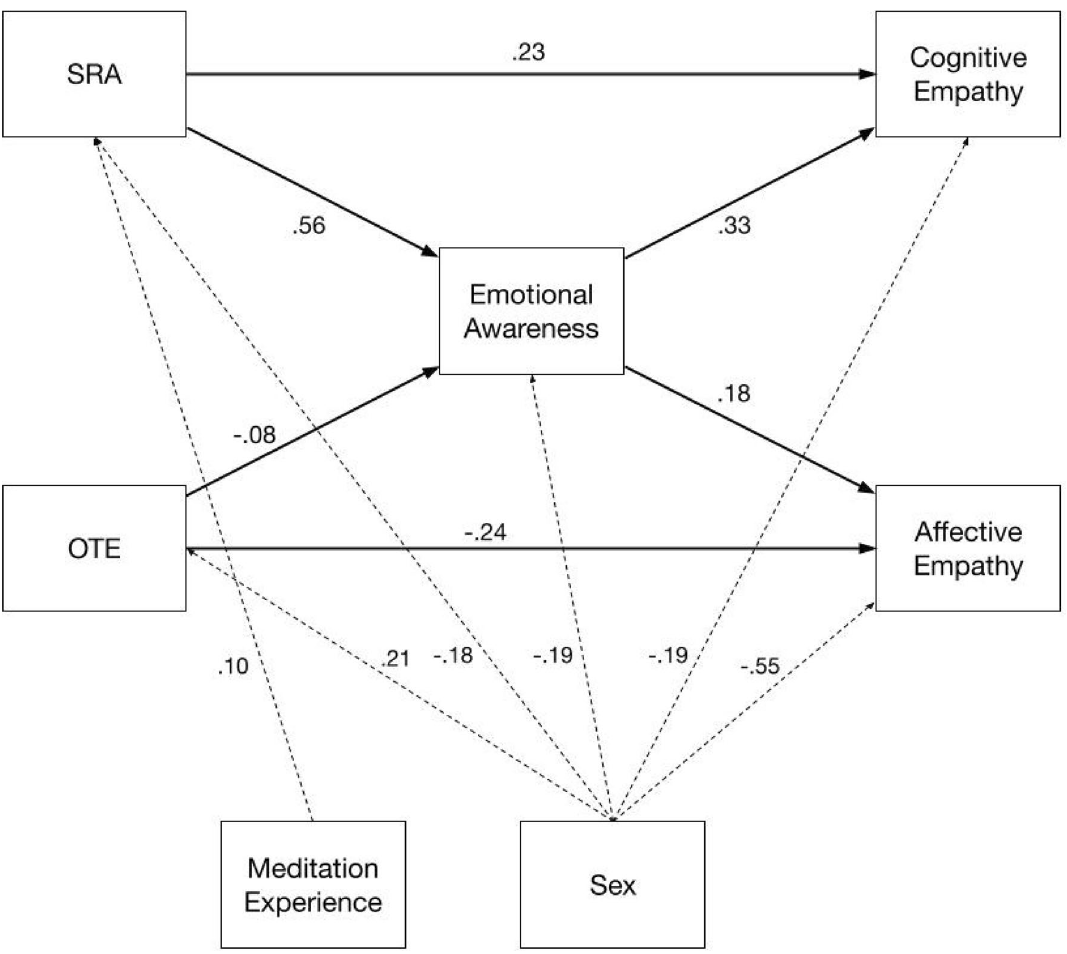
Figure 2. Associations between two higher-order-factors of mindfulness, emotional awareness, and cognitive and affective empathy. SRA = Self-regulated Attention, OTE = Orientation to Experience. Numbers are standardized path coefficients. Only significant direct and indirect paths ( p < 0.05; see Table 2) and confounding effects of meditation experience and participants’ sex (see Table S3) are displayed. Significance was determined via 95% bias-corrected